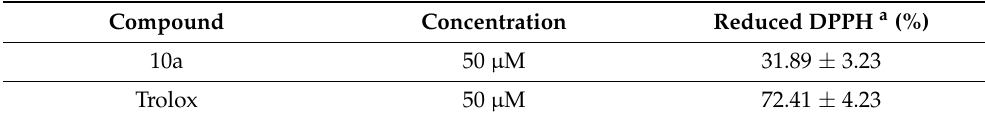
Table 2. The antioxidant activity of compound 10a .